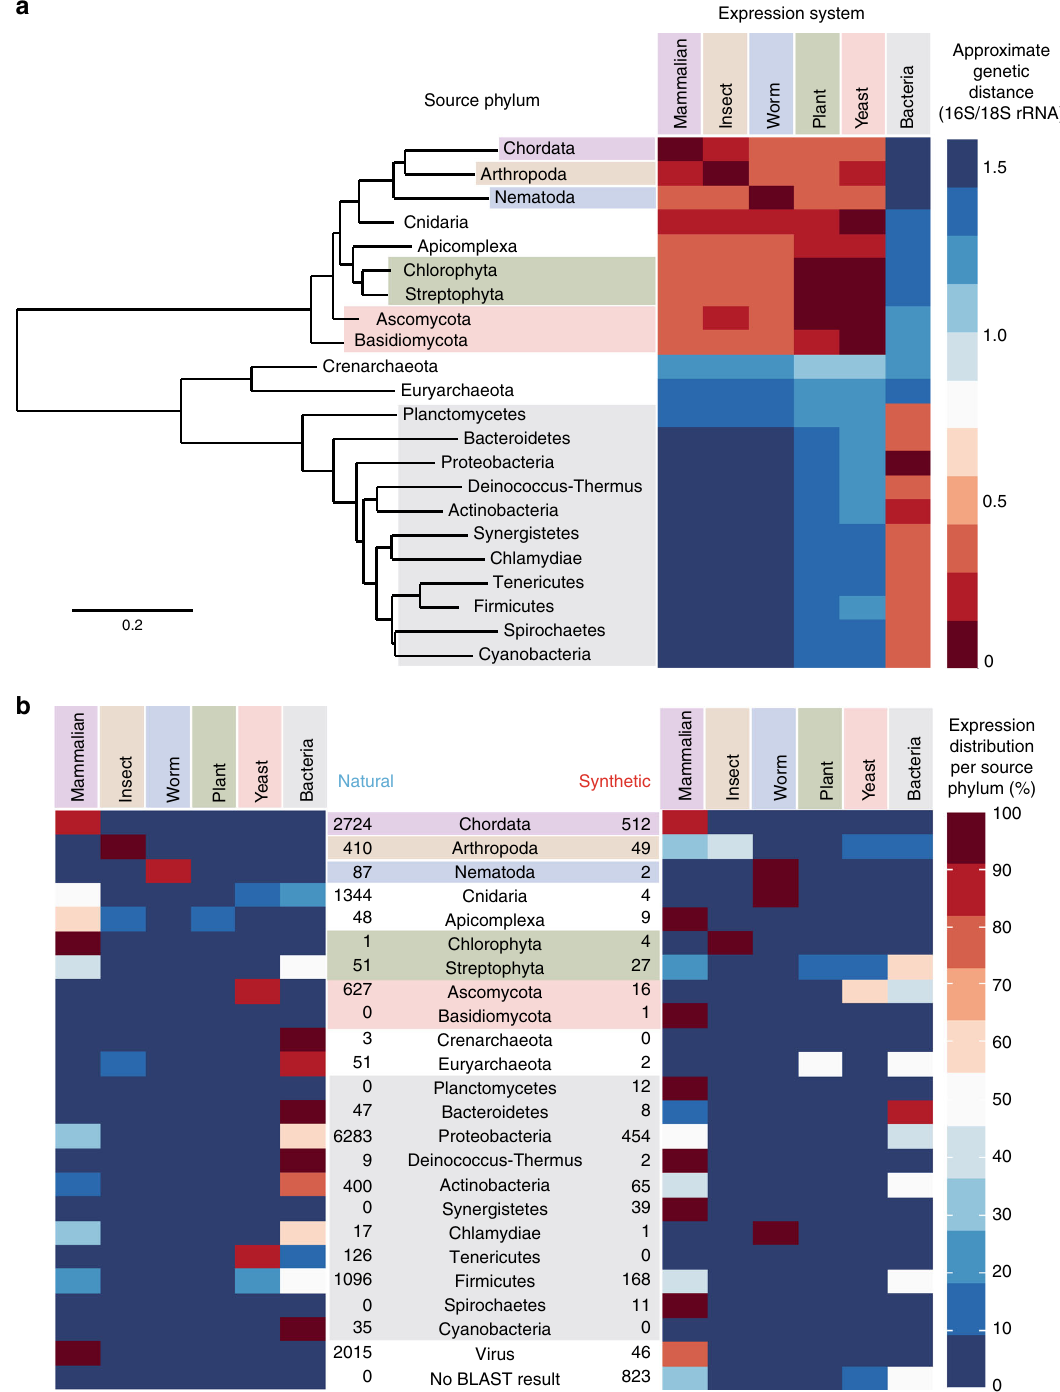
Fig. 3 Mapping of genetic distances and transgene expression for Addgene sequences. a Phylogenetic tree of the most common source phyla and corresponding heatmap displaying genetic distance of different expression platforms. b Heatmaps displaying source phylum and expression platform for (left) natural and (right) synthetic